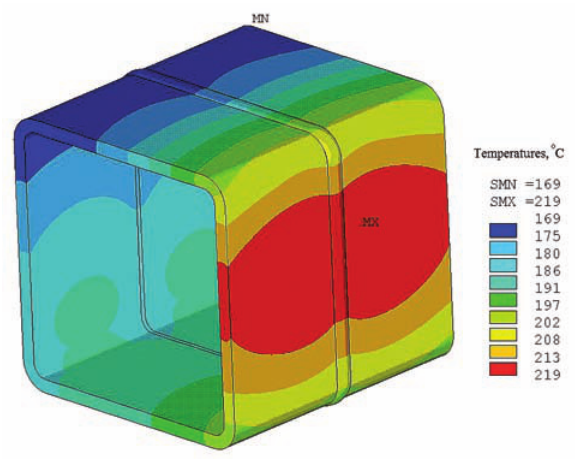
Fig. 15. Residual stresses distribution on control line points x, y and z axis-vise as joint is cooling down to room temperature, MPa